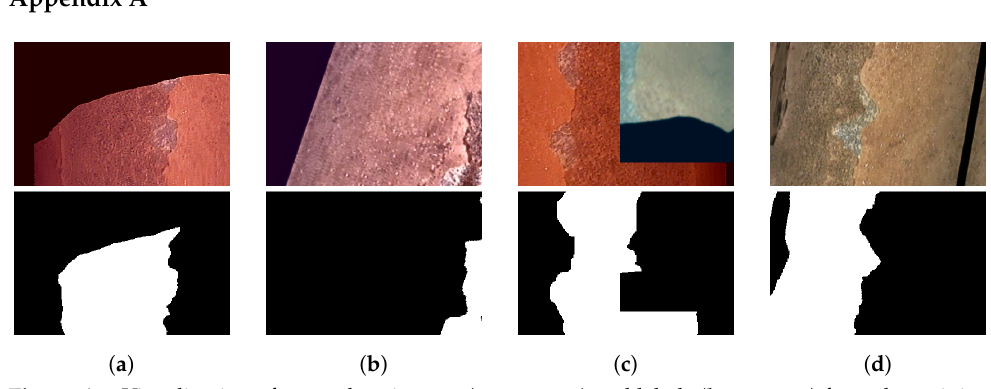
Figure A1. Visualization of exemplary images ( upper row ) and labels ( lower row ) from the training dataset with applied augmentations. On the patch depicted in ( a ) a color channel shift is applied. In ( b ), the application of a rotation and histogram equalization can be seen. The patch depicted in ( c ) shows, among others, an applied CutMix operation, where an ROI of another patch from the same batch is inserted into the shown patch on the upper right . The label is adjusted accordingly. The image patch depicted in ( d ) is rotated and additionally mirrored in places where black areas would appear otherwise (see lower right corner of the depicted image